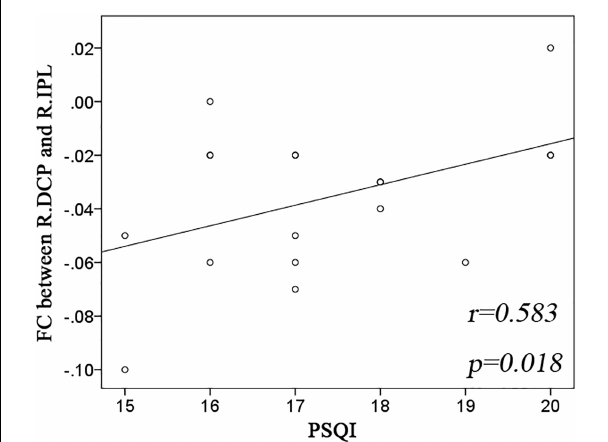
FIGURE 3 | Significant correlation between striatal connectivity and PSQI. Significant positive correlation was observed in the functional connectivity (FC) between the right dorsal caudate putamen (R.DCP) subregion and right inferior parietal lobe (R.IPL) with Pittsburgh Sleep Quality Index